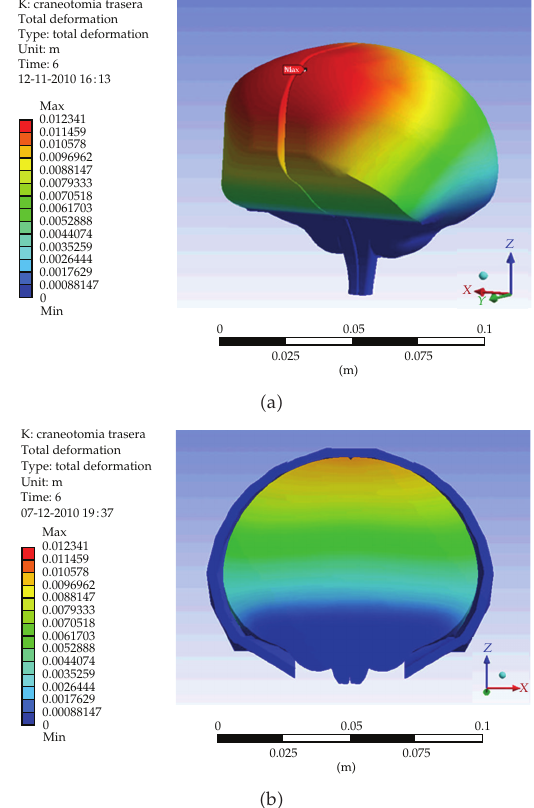
Figure 12: Brain displacement for posterior craniotomy, hyperelastic second-order Ogden model.